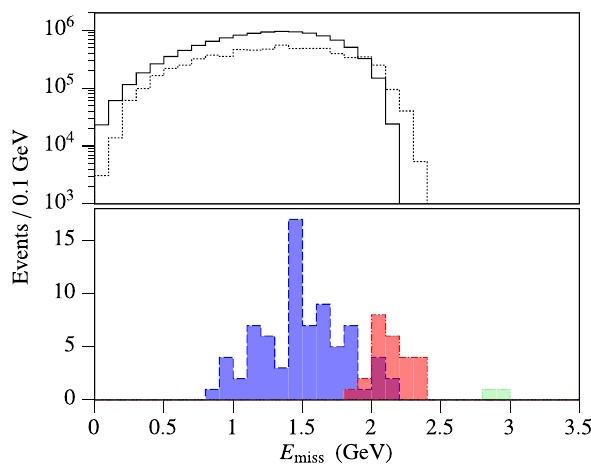
SM and SM background processes are very large and, hence, those are shown with the vertical axis in log-scale, while the NP scenarios are shown in a linear